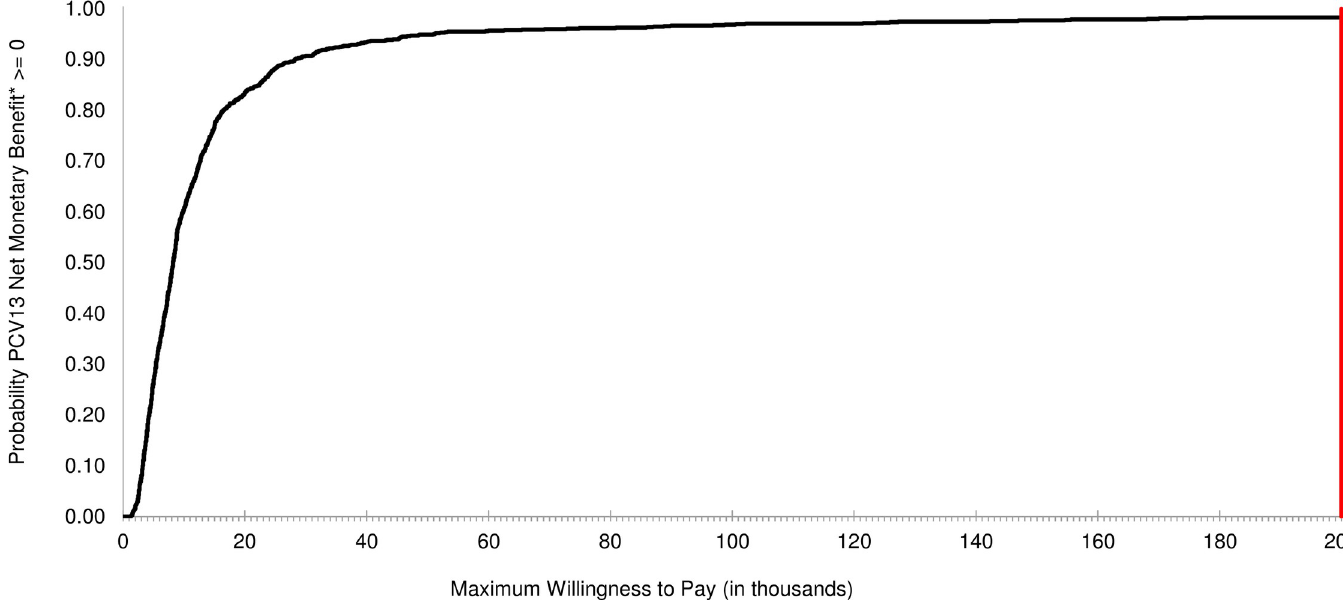
Fig 6. Cost-effectiveness acceptability curve: Public health care sector mixed model. Costs are indicated in 2015 South African rand.